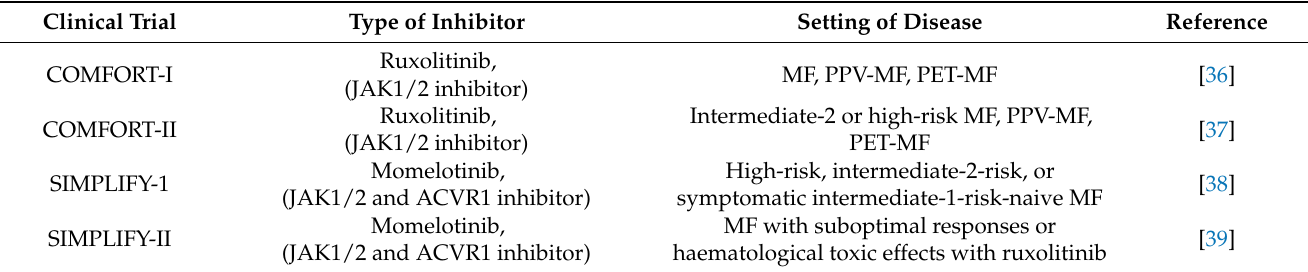
Table 1. Some clinical trials including JAK2 inhibitors for MPN patients. PPV-MF,